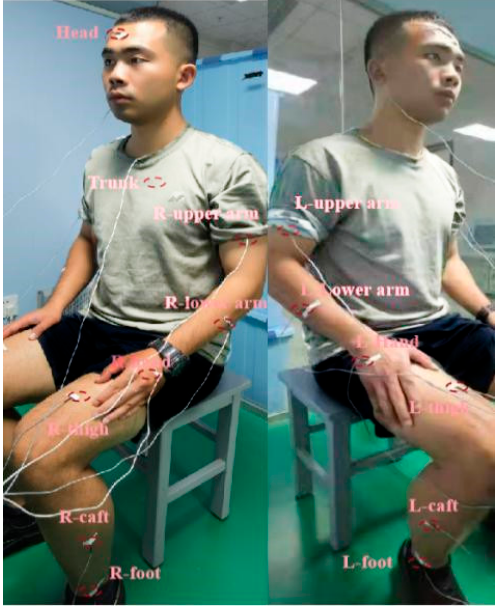
Figure 7. Distribution of human body temperature measurement points.